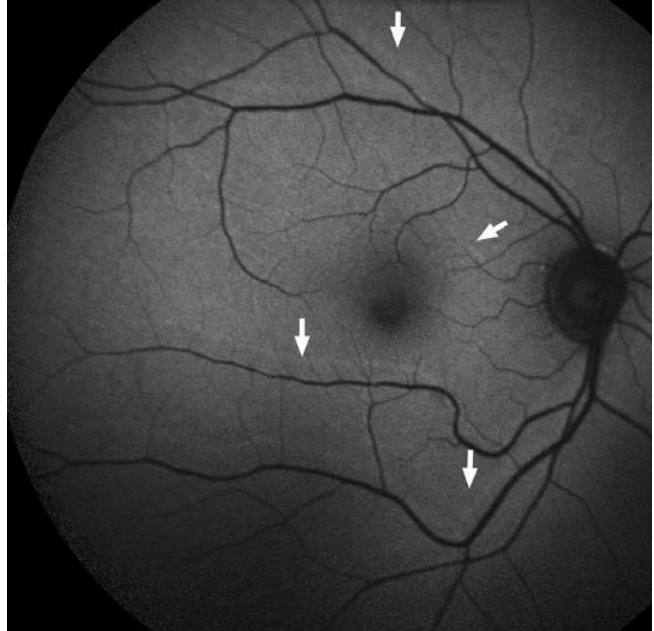
Figure 5. Fundus autofluorescence image of an individual following retinal detachment repair. Hyperautofluorescent lines follow a course that parallels the retinal vessels